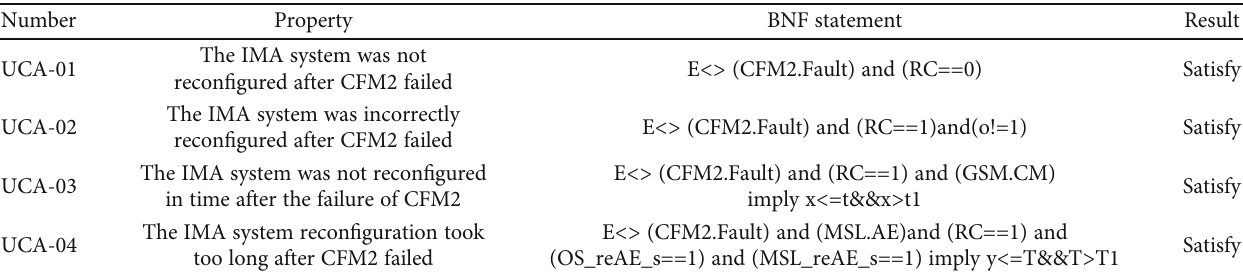
Table 4: UCA validation